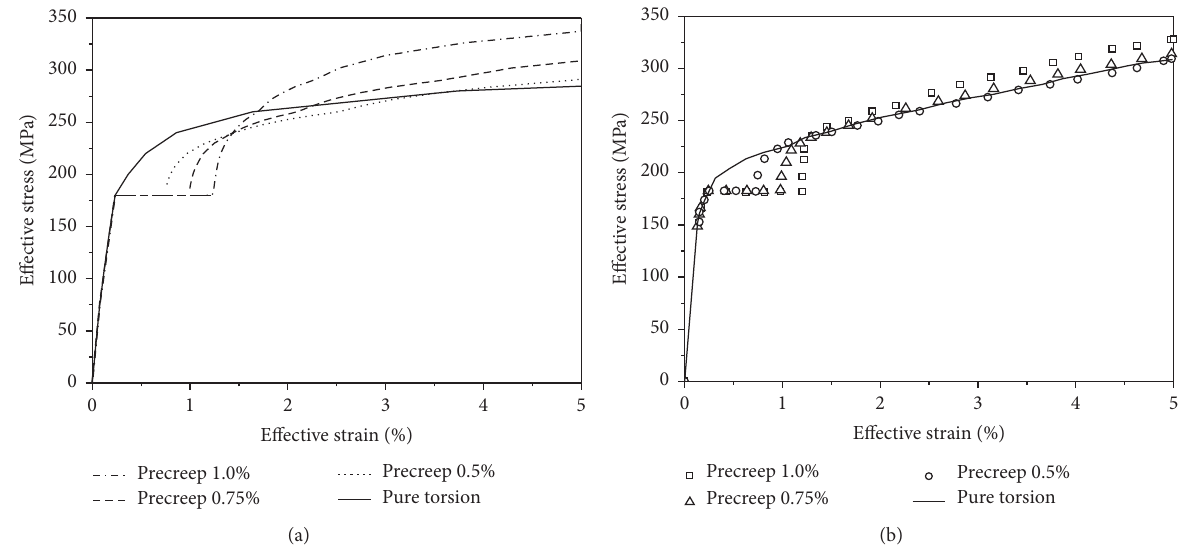
Figure15:Effectsofthepriorcreepstrainonthesubsequentplasticdeformationfora316stainlesssteelby(a)simulationsand(b)experiments [18].